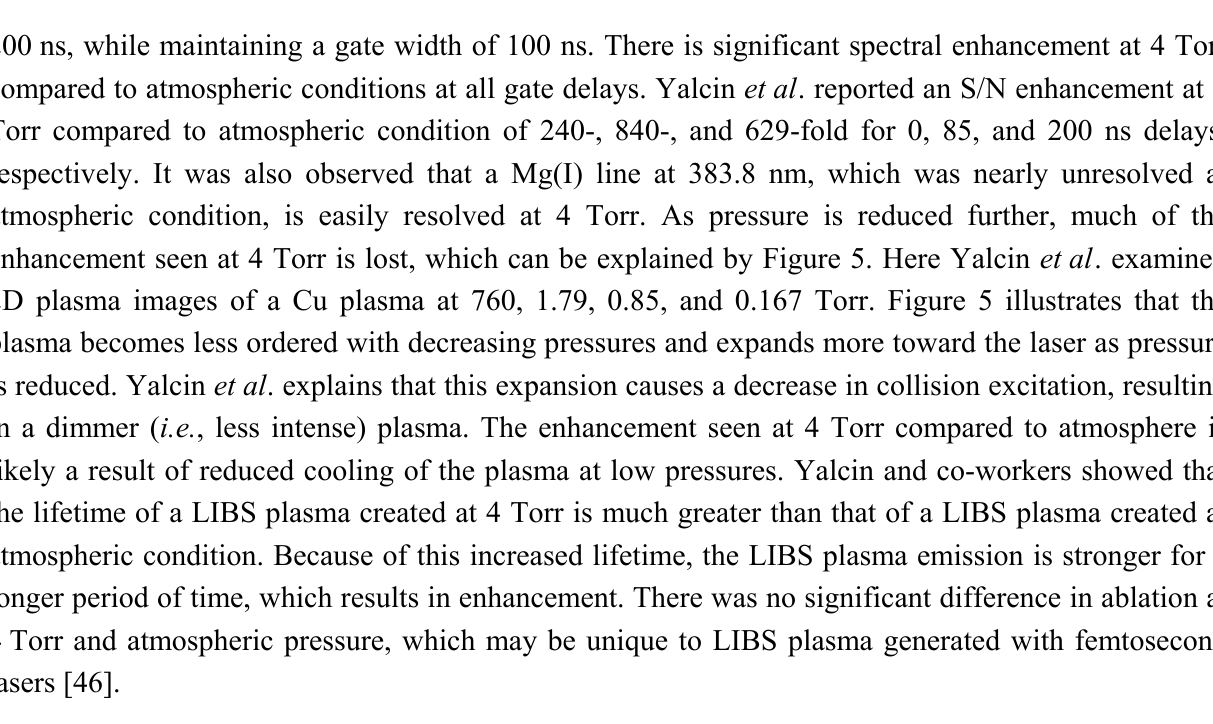
Figure 4. LIBS spectra of Al at atmospheric conditions (a–c) and at 4 Torr (d–f) with increasing delay times (0, 85 and 200 ns). Reprinted from reference